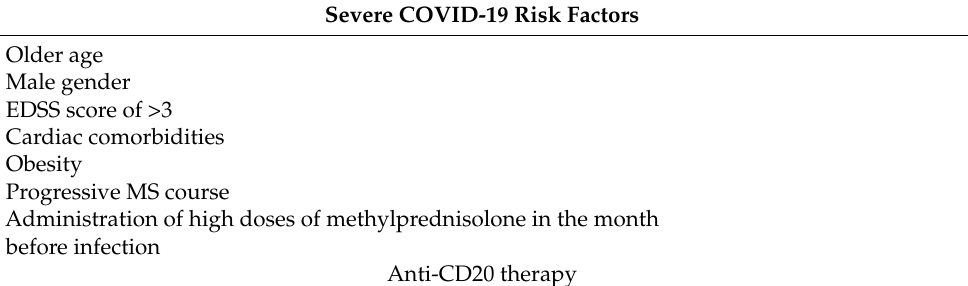
Table 1. Risk factors for severe COVID-19